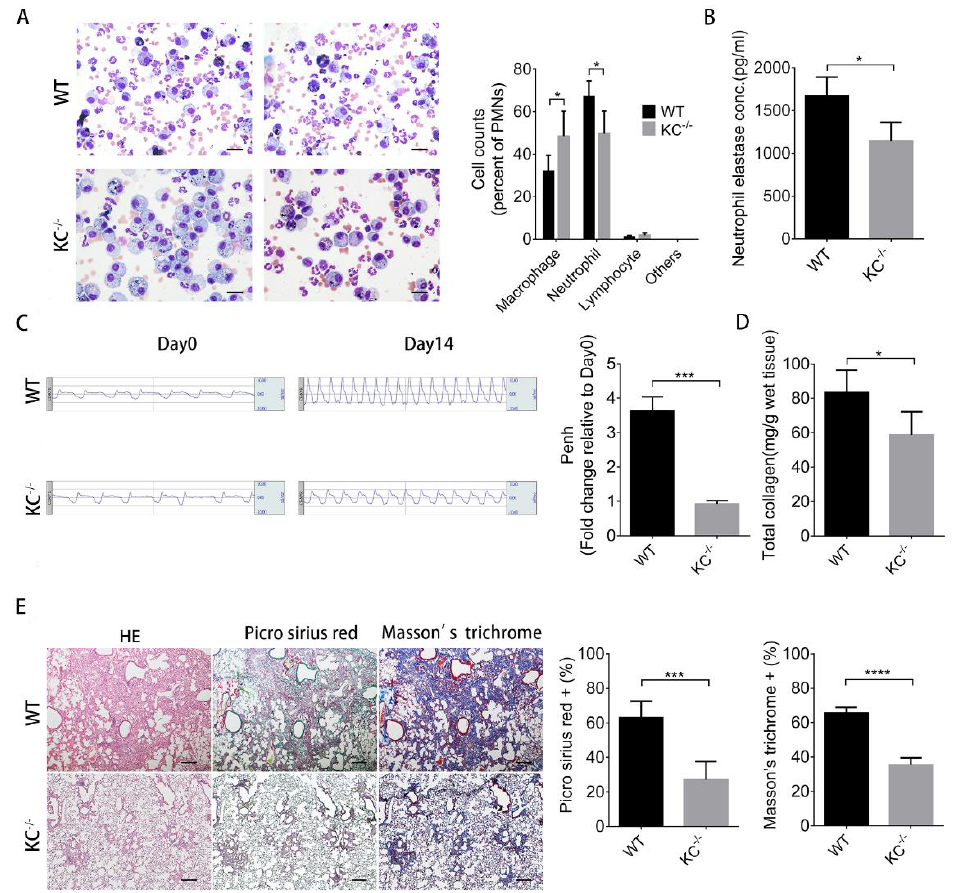
Figure 5. Increased severity of bleomycin-induced pulmonary fibrosis caused by particulate matter (PM) was diminished in KC knockout mice. KC knockout mice (KC −/− ) and wild-type littermates (WT) were intratracheally instilled with 200 μg particulate matter plus 2 U/kg bleomycin. ( A , B ) The mice were sacrificed and the BALF were harvested at 2 days for ( A ) Liu’s staining (400×) and quantification of the changes in the immune cell profile. (scale bar: 20 µm) ( B ) The concentration of neutrophil elastase was measured by ELISA. ( C ) The lung function test for Peng value was performed at 14 days. The mice were then sacrificed and the lung tissues were subjected to ( D ) total collagen content measurement and ( E ) histochemical analysis with H&E, Picro Sirius red, and Masson’s trichrome staining (40×) Quantification data are expressed as the mean ± SD of four mice in each group. (scale bar: 200 µm) * p < 0.05, *** p < 0.005, **** p < 0.001 as determined by Student’s t test.